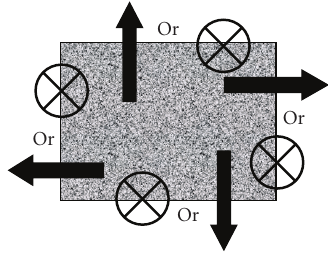
Figure 4: Illustration of the starting